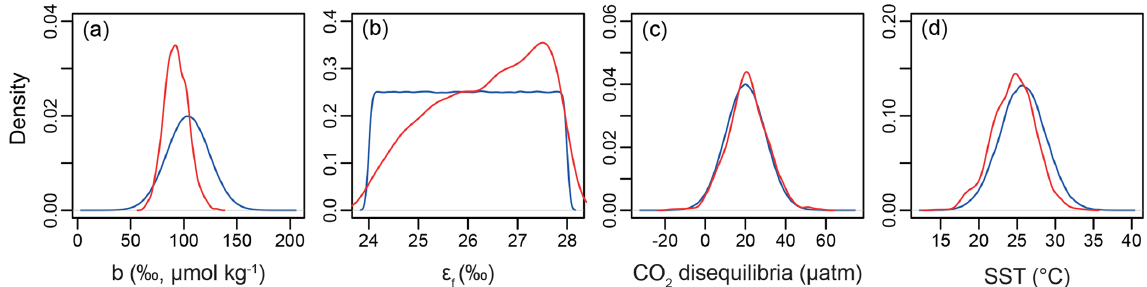
proxy; the sample shown is 0.15Ma from ODP Site 999. In all panels, the Figure 8. Example of the Bayesian treatment of the CO 2( ε p − alk) prior is shown in blue and the posterior in red. (a) The b term, (b) ε f , (c) the extent of CO 2 disequilibria, and (d) sea surface temperature.